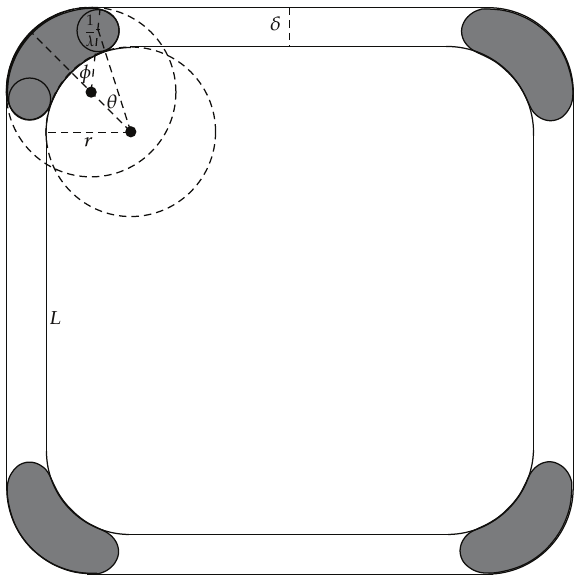
Figure 4: Square Annulus with angles φ and θ